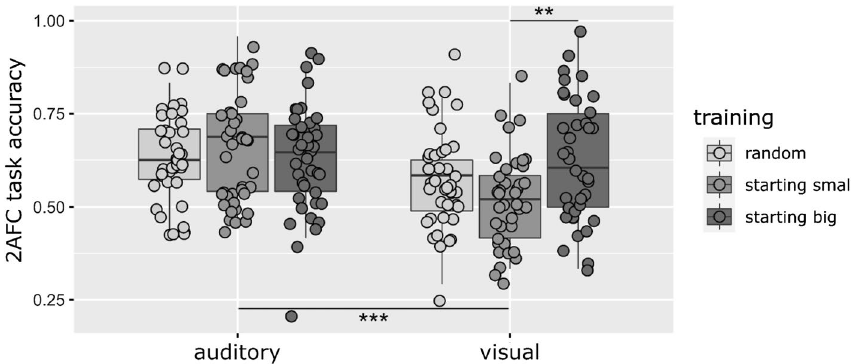
Figure 5. 2AFC accuracy in the Modality*Training Type interaction in the case of serial presentation. Dots represent the mean accuracies of individual participants in a given group (a small amount of jitter was added to increase visibility). Lines in boxes represent group medians, box lengths illustrate the group interquartile range, and whiskers show minimum and maximum values. Outliers are participant data which are outside the 1.5 interquartile range beyond the first and third quartiles. *: p < 0.05, **: p < 0.01, ***: p < 0.001. Performance was significantly lower in the visual starting small condition than performance in the auditory starting small condition and performance in the visual starting big condition (regardless of Domain).